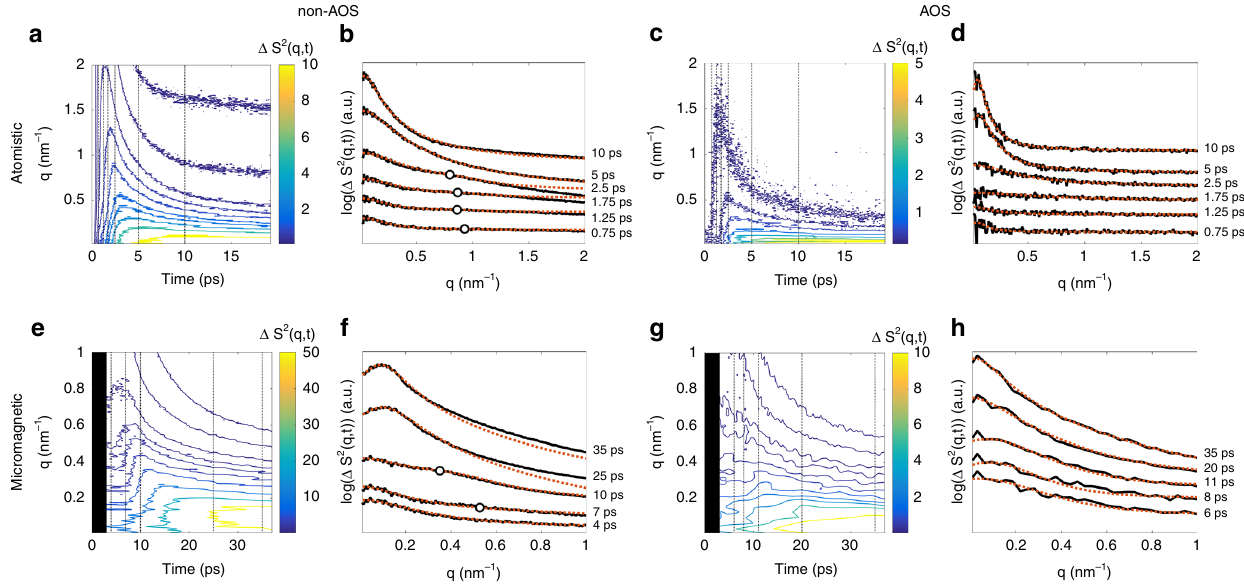
Fig. 5 Simulated spin – spin correlation functions. a Contours of the azimuthally averaged spin – spin correlation function obtained from atomistic simulations in the non-AOS case. For the time instances indicated by dotted vertical lines, lineouts are shown by black curves in ( b ) and are vertically shifted for clarity. Fits using Lorentzian and Gaussian components are shown by red dashed lines. The ring radius of the Gaussian component is shown by black circles. Equivalent plots for the case of AOS are shown in panels ( c ) and ( d ). Fits to the lineouts in this case are obtained by using only a Lorentzian line-shape. For micromagnetic simulations seeded with an atomistic input at 3 ps, the azimuthally averaged spin – spin correlation function and corresponding lineouts and fi ts are shown in ( e ) and ( f ) for non-AOS; and ( g ) and ( h ) for